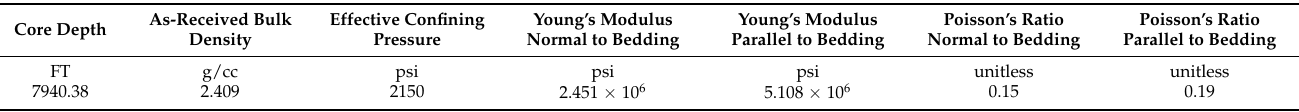
Table 2. Geomechanical properties courtesy of Schlumberger Reservoir Laboratory 2 September 2020.